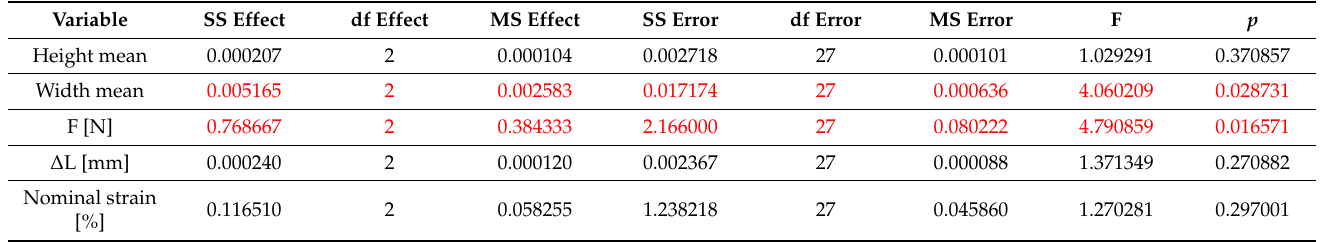
Figure 3. Compressive modulus of elasticity of the three dental materials and the result of the Kruskal-Wallis and post hoc tests. Because variances di ff ered between the groups, in addition to the Brown–Forsythe test, the ANOVA test with the Welch amendment was carried out. The homogeneity vari- ance test is presented in Table 4 and the Welch amendment is presented in Table 5. These tables apply to the comparison between all three materials. Table 4. Homogeneity variance test according to Brown–Forsythe (the statistical signi fi cance for p < 0.05 is presented in red). SS—sum of squares; MS—mean sum of squares; df—degrees of freedom; F—force; Δ L—decrease in the distance between the plates.